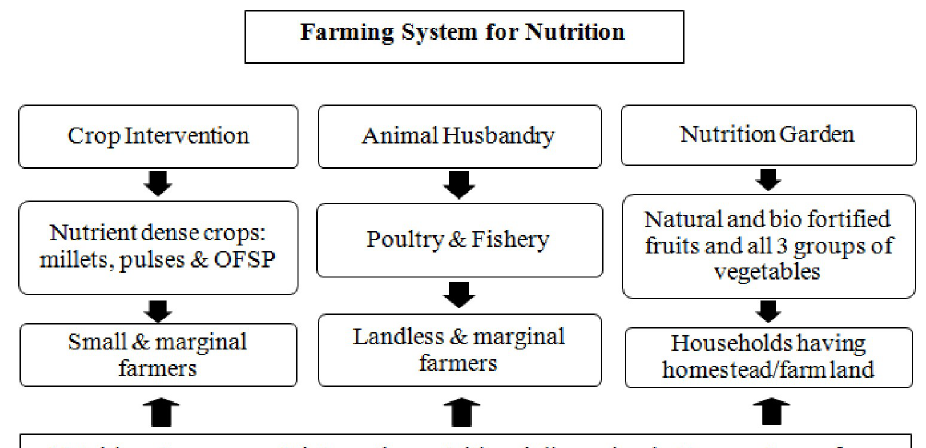
Fig 1. Farming System for Nutrition